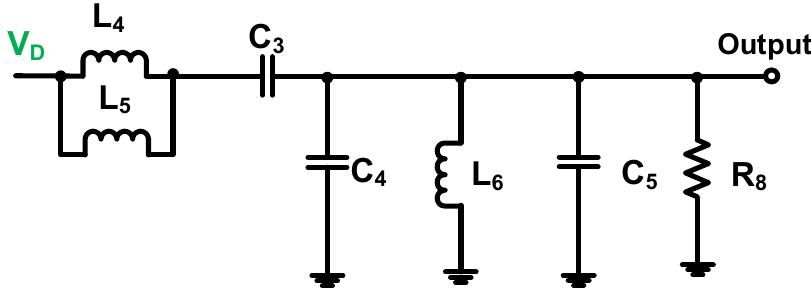
6 of 16 Figure 3. Schematic diagram of the input matching network. As shown in Figure 4, the output matching network is a low-pass filter network. Moreover, the inductances (L 4 and L 5 ) and the capacitance (C 3 ) are parallel to the capaci-